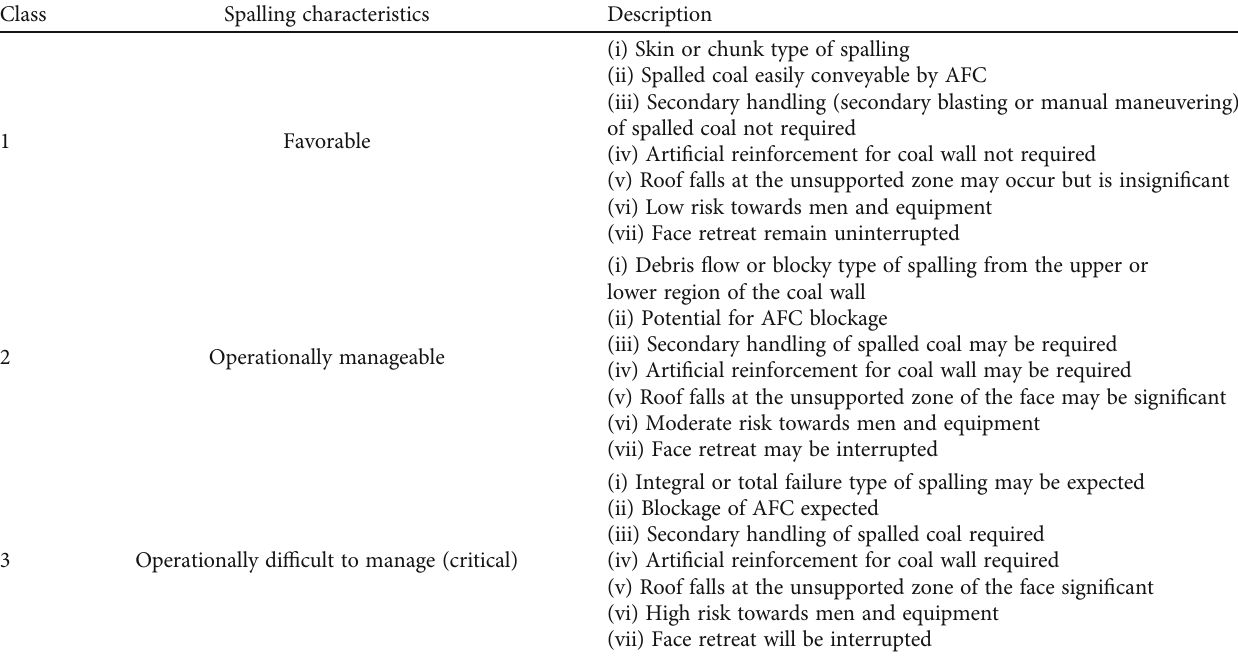
Table 7: Coal wall spalling classi fi cation based on CWSC system.